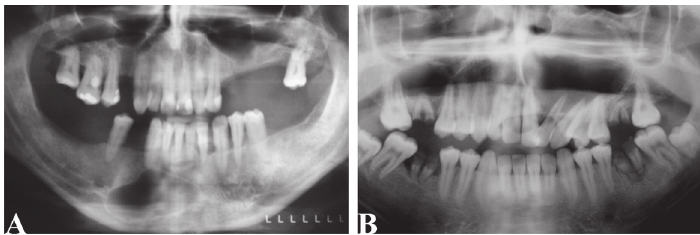
Figure 1- Panoramic radiographs: A, classical cyst aspect as a unilocular radiolucency lesion with well-defined sclerotic margins in a mandible residual cyst; B, maxillary keratocystic odontogenic tumor with unusual bone expansion and tooth